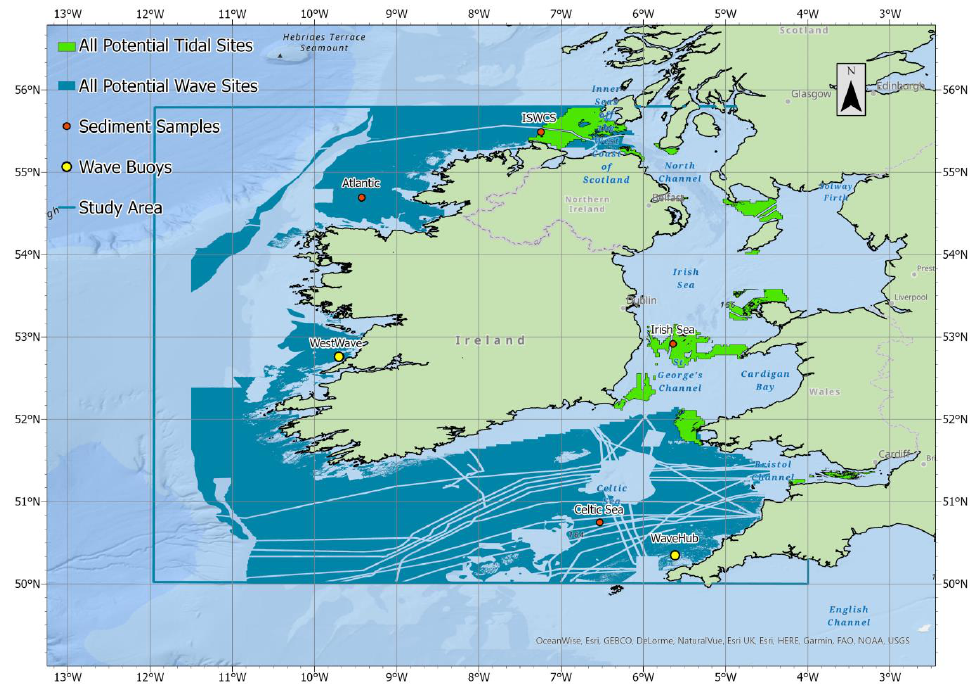
Figure 24. In situ validation points with reference to the potential wave and tidal energy sites.